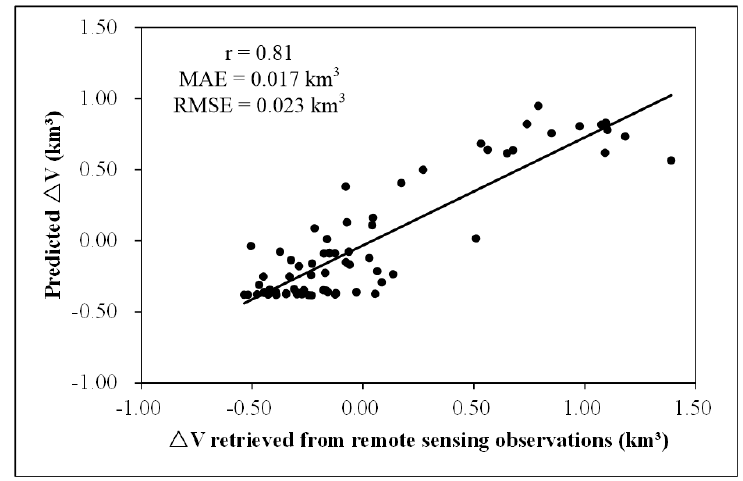
Figure 19. Scatterplots of ∆(cid:1848) retrieved from remote sensing observations and ∆(cid:1848) retrieved from the regression model.